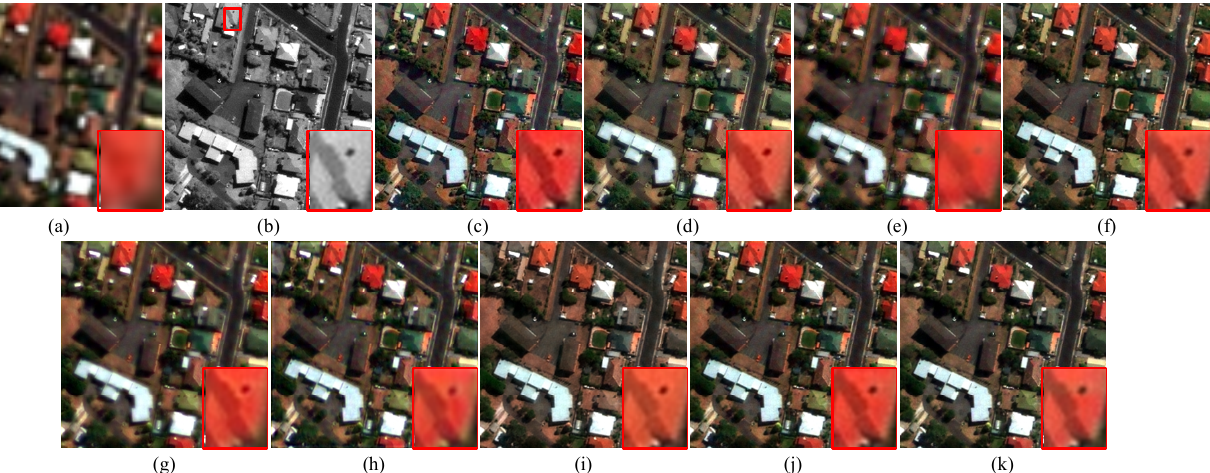
Figure 7. Visual analysis of the fused images from different methods on the GeoEye-1 dataset. ( a ) LR MS image; ( b ) PAN image; ( c ) BDSD; ( d ) SVT; ( e ) VPLGC; ( f ) A-PNN; ( g ) DRPNN; ( h ) PanNet;